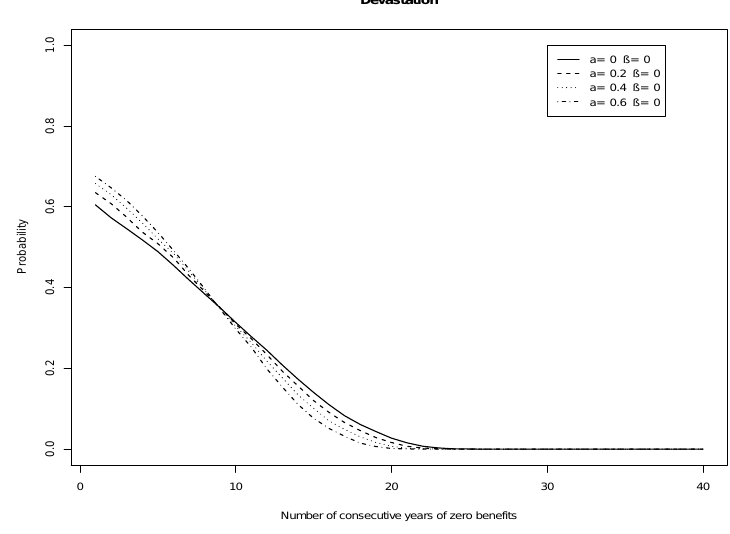
Figure 3. Devastation. The number of consecutive years in which there is no retirement benefit paid to a retiring generation, plotted against the probability. The investment risk adjustment ( a ) is varied and the AAF adjustment ( b ) is set equal to zero, and the target funding level ¯ F = 100%. Plotting the devastation measure for plans in which only the AAFs are adjusted, Figure 4 is obtained. Here, the difference of the risk-sharing plans from the benchmark plan is dramatic. The chance of the risk-sharing plans running out of money is significantly less than for the benchmark plan. The higher the value of the AAF adjustment b , the lower is this probability. However, it is important to note that although the members may receive something, the amount of their retirement benefits may be